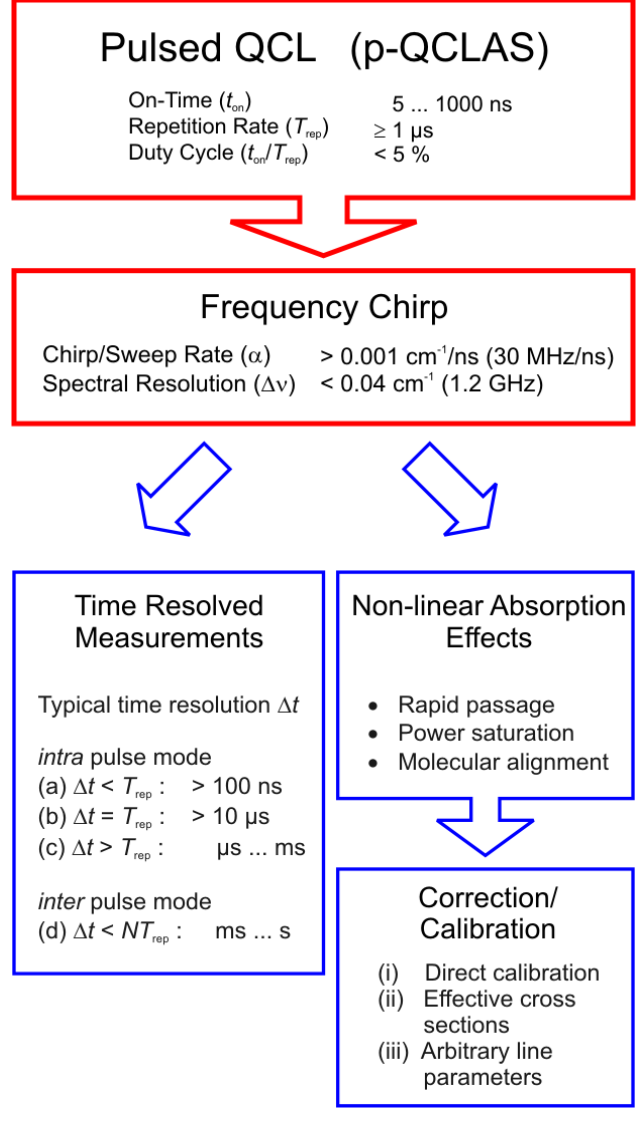
Figure 2. Overview of issues occurring in